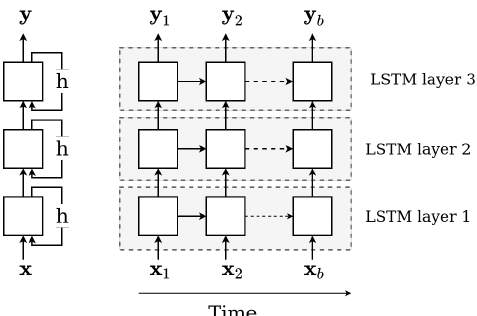
Figure A5. A deep RNN unrolled through time. The output of layer 1 is the input to layer 2. At each time step, each recurrent neuron will receive the input x t